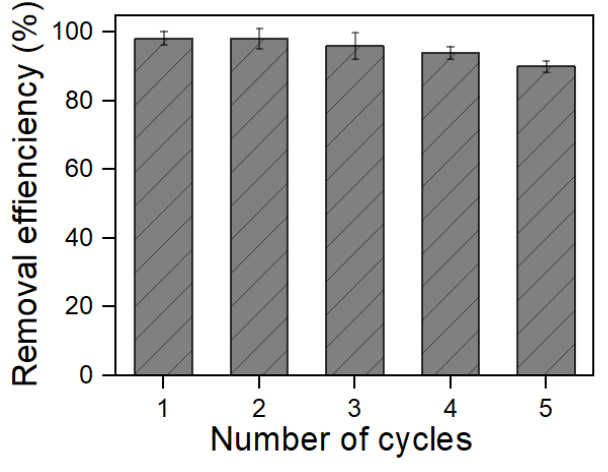
Figure 11. Effects of recyclability of CS 2 C@SBA − 3 on V(V) removal. Condition: V(V) initial concentration = 100 ppm, CS 2 C@SBA − 3 dosage = 1.0 g/L, pH value = 3.0, experimental temperature = 298 K, contact time = 24 h.